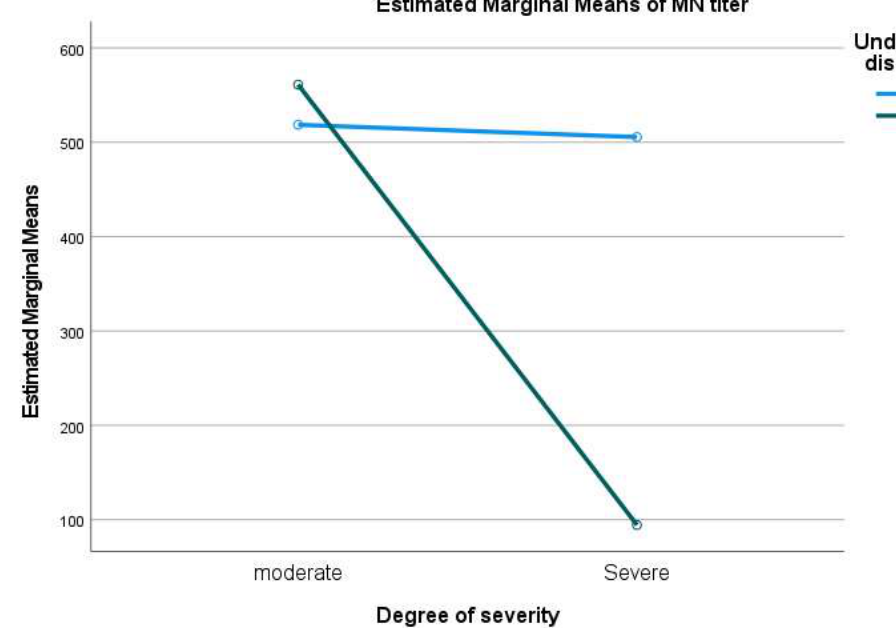
Figure 1. Univariate analysis MN titers versus degree of severity and underlying diseases.